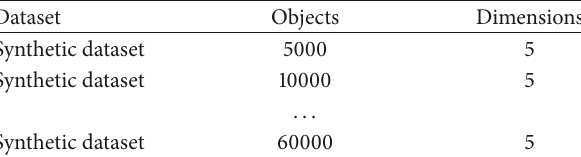
Table 1: Test datasets